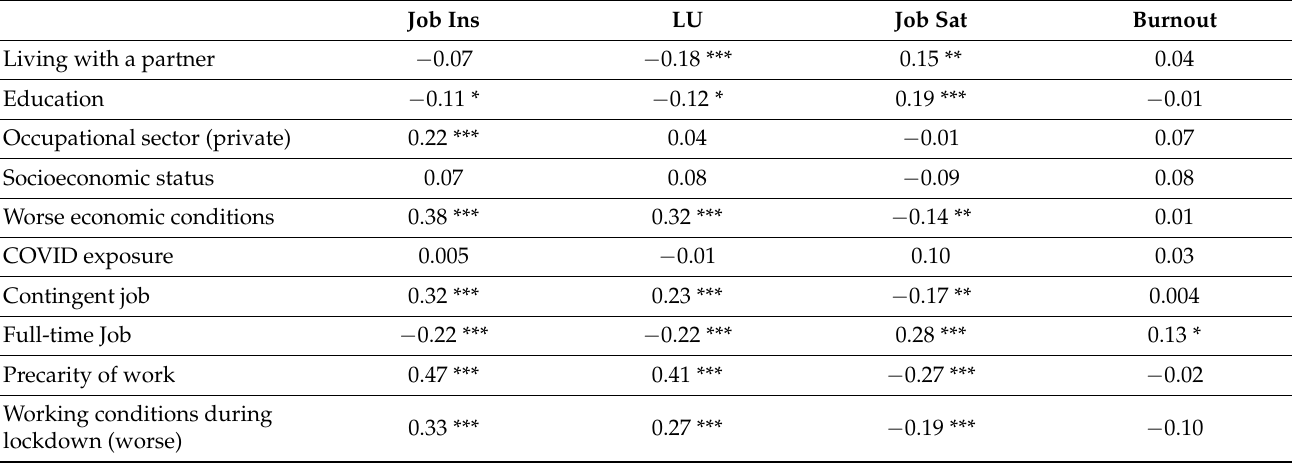
Table 3. Correlations with sociodemografic and contextual